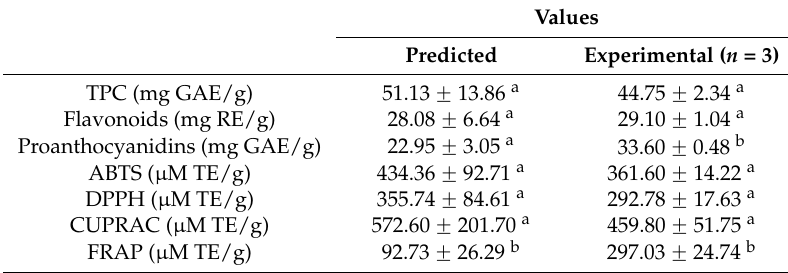
Table 5. Validation of the predicted values for TPC, flavonoids, proanthocyanidins, and antioxidant